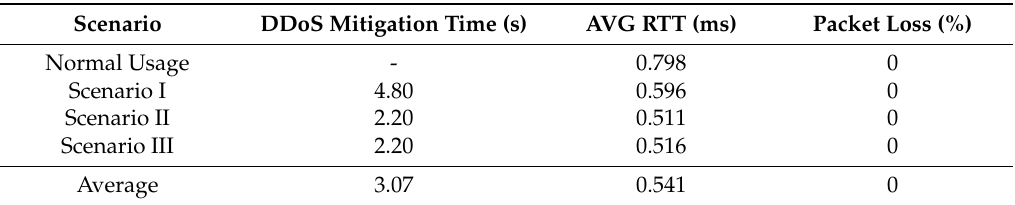
Table 7. Comparison among the Results obtained from Our Evaluation